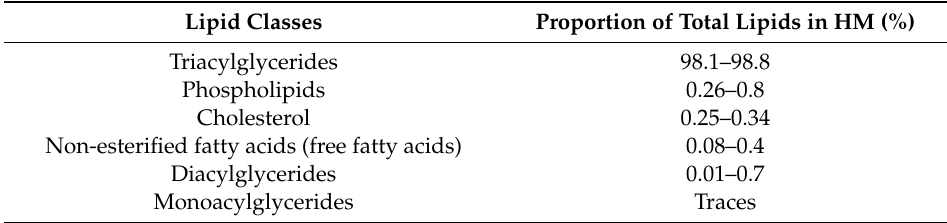
Table 1. Lipid classes in human milk (HM). Adapted from